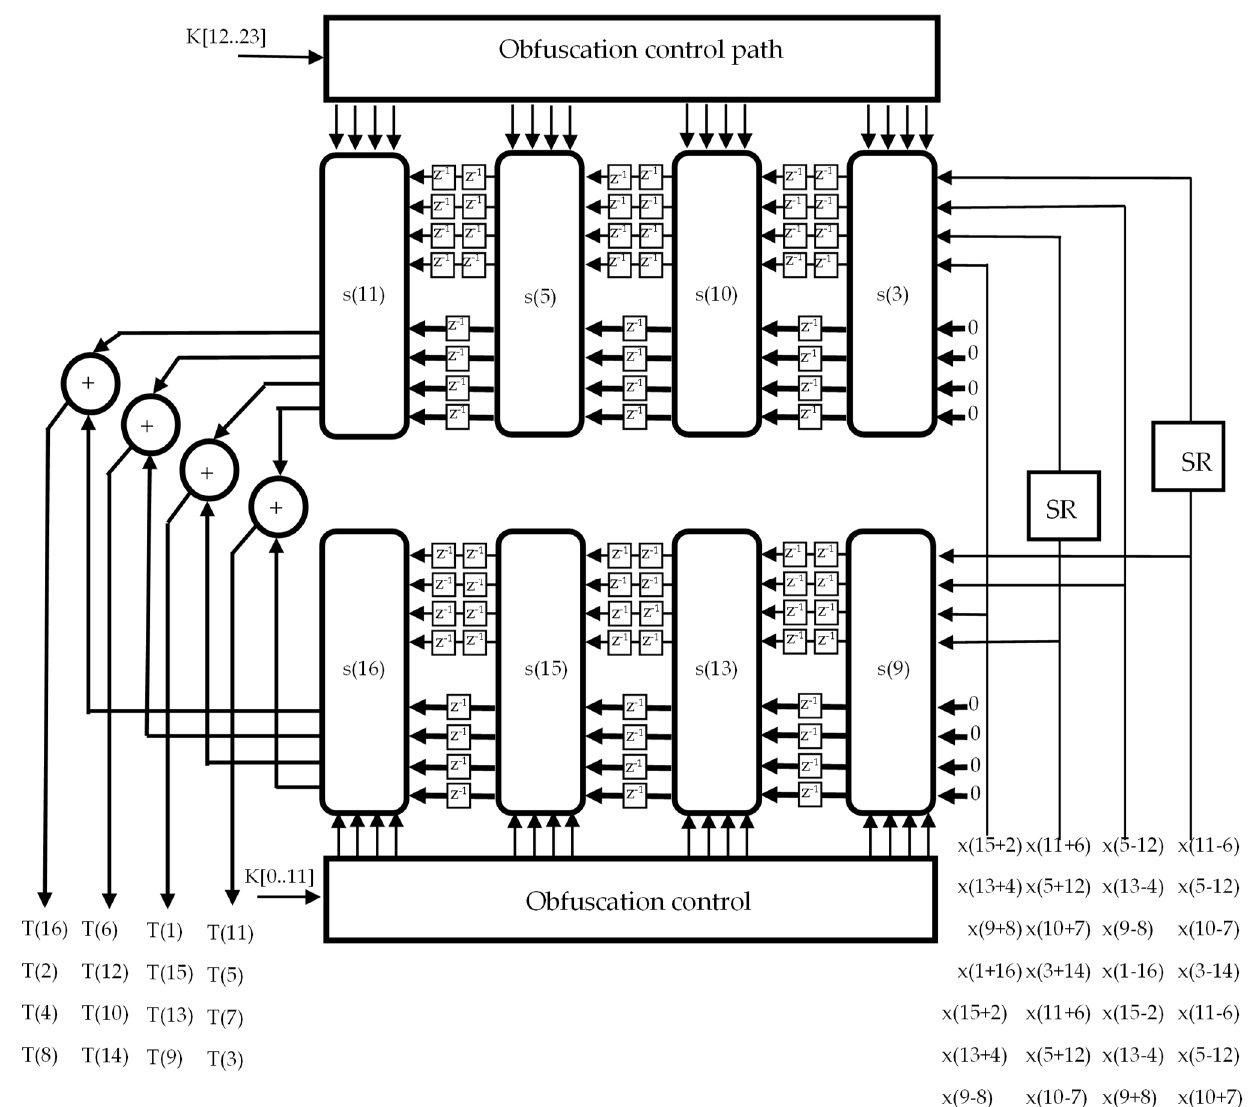
Figure 2. The VLSI architecture for the hardware core of the 1-D DST.